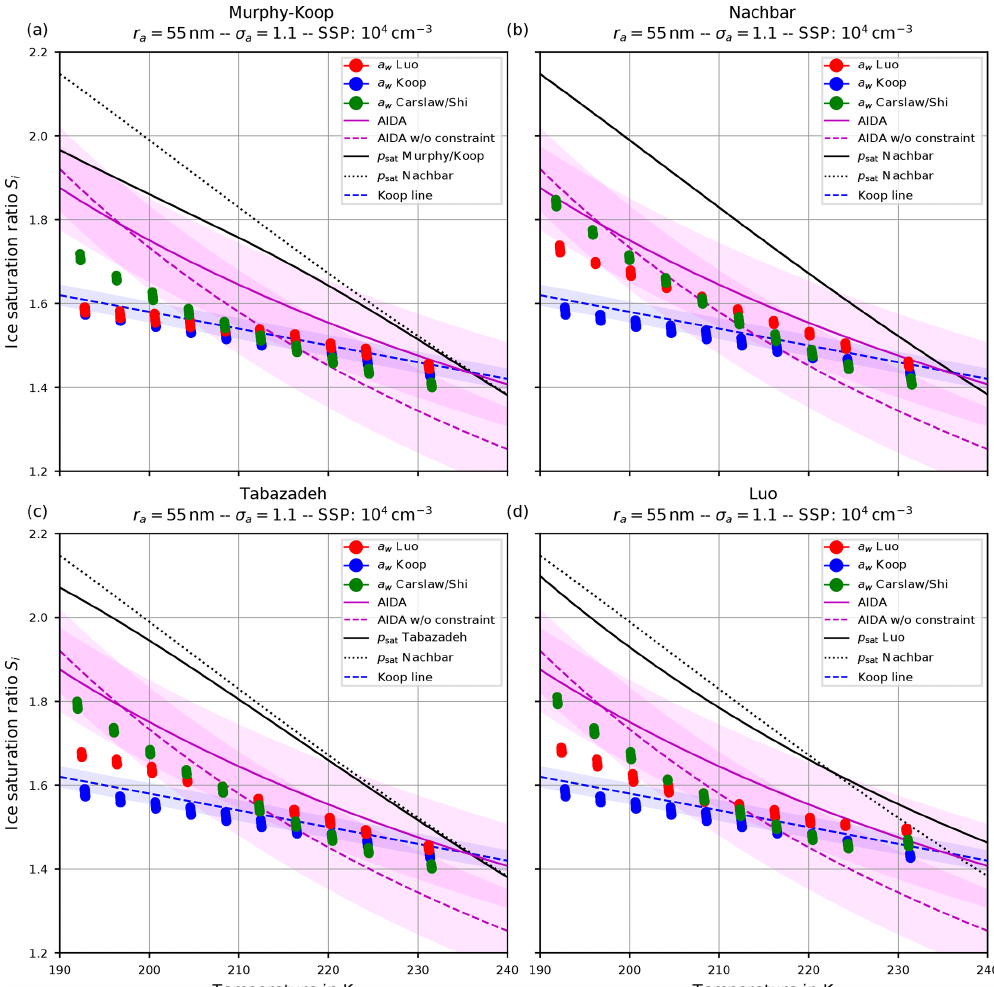
Figure 9. Ice onset as a function of temperature for the same scenarios as in Fig. 6 with the choice σ a = 1 . 1 for the dry aerosol lognormal size distribution. In this plot, each air parcel simulation with a different updraft velocity is represented as a dot, and the colors indicate the employed water activity formulation. Magenta lines indicate fits to the AIDA measurements, while the shaded areas show a ± 0 . 1 uncertainty range. The blue dashed line indicates a Koop line and the black dotted line the values of p sat , Nach . The solid black line shows the values of the saturation vapor pressure formulation indicated in the panel’s title. Note that SSP refers to the sulfuric acid aerosol particles (small solution